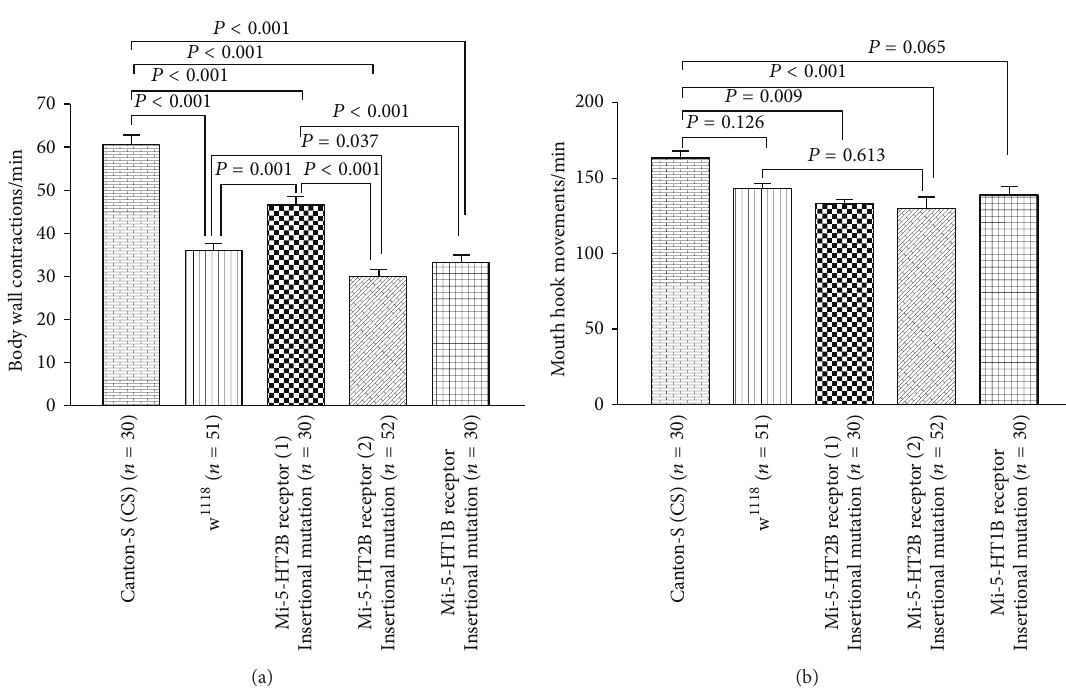
Figure 8: Manipulation in expression of mutated 5-HT receptors. (a) In all mutant lines, body wall contractions were significantly reduced in comparison to CS flies. However, 5-HT2B receptor (line 2) insertional mutant larvae significantly reduced body wall contractions in comparison to w 1118 larvae. (b) Mouth hook movements were significantly affected in 5-HT2B receptor mutations in comparison to CS larvae, although mouth hook movements in 5-HT2B receptor (line 2) insertional mutant larvae were not significantly reduced compared to w 1118 larvae. One-way ANOVA was used for comparison, and Bonferroni 𝑡 -test was employed to compare treatments. Data represented as mean ± SEM. 𝑃 value < 0.05 is